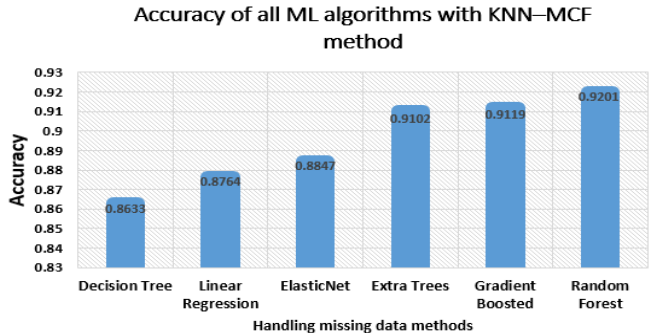
Figure 5. Accuracy of all machine learning algorithms with respect to the KNN–MCF method.